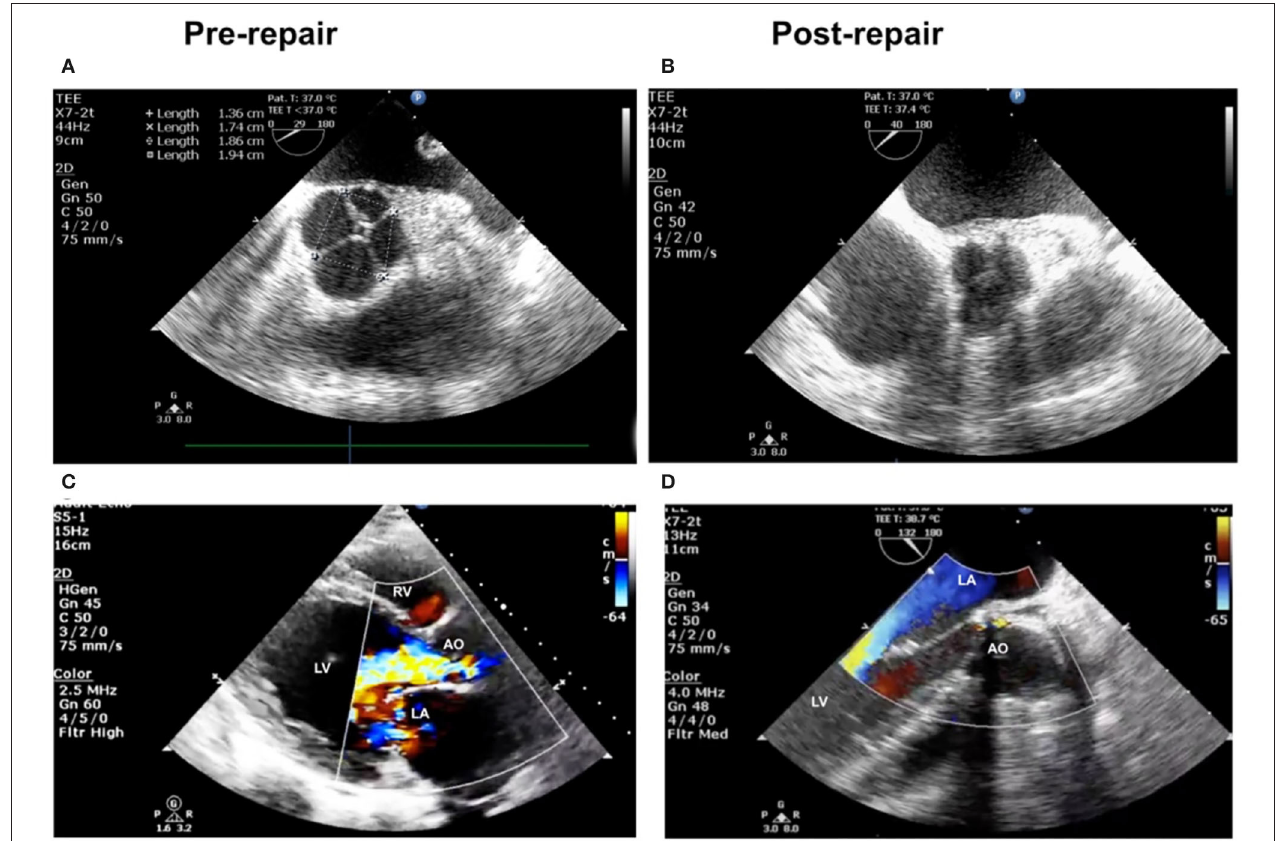
FIGURE 1 | (A) Pre-operation: quadricuspid aortic valve (QAV). (B) Post-operation: QAV to tricuspidization aortic valve (TAV). (C) Transthoracic echocardiogram (TTE) demonstrated severe regurgitation before operation. (D) Post-operation image of transesophageal echocardiography (TEE) showed no regurgitation.